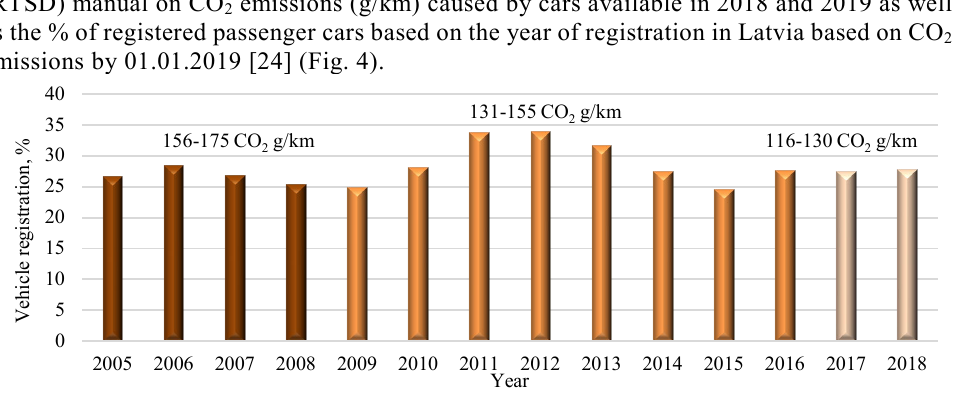
Fig. 4. Registered vehicles % by year in Latvia according to CO 2 emissions by 01.01.2019